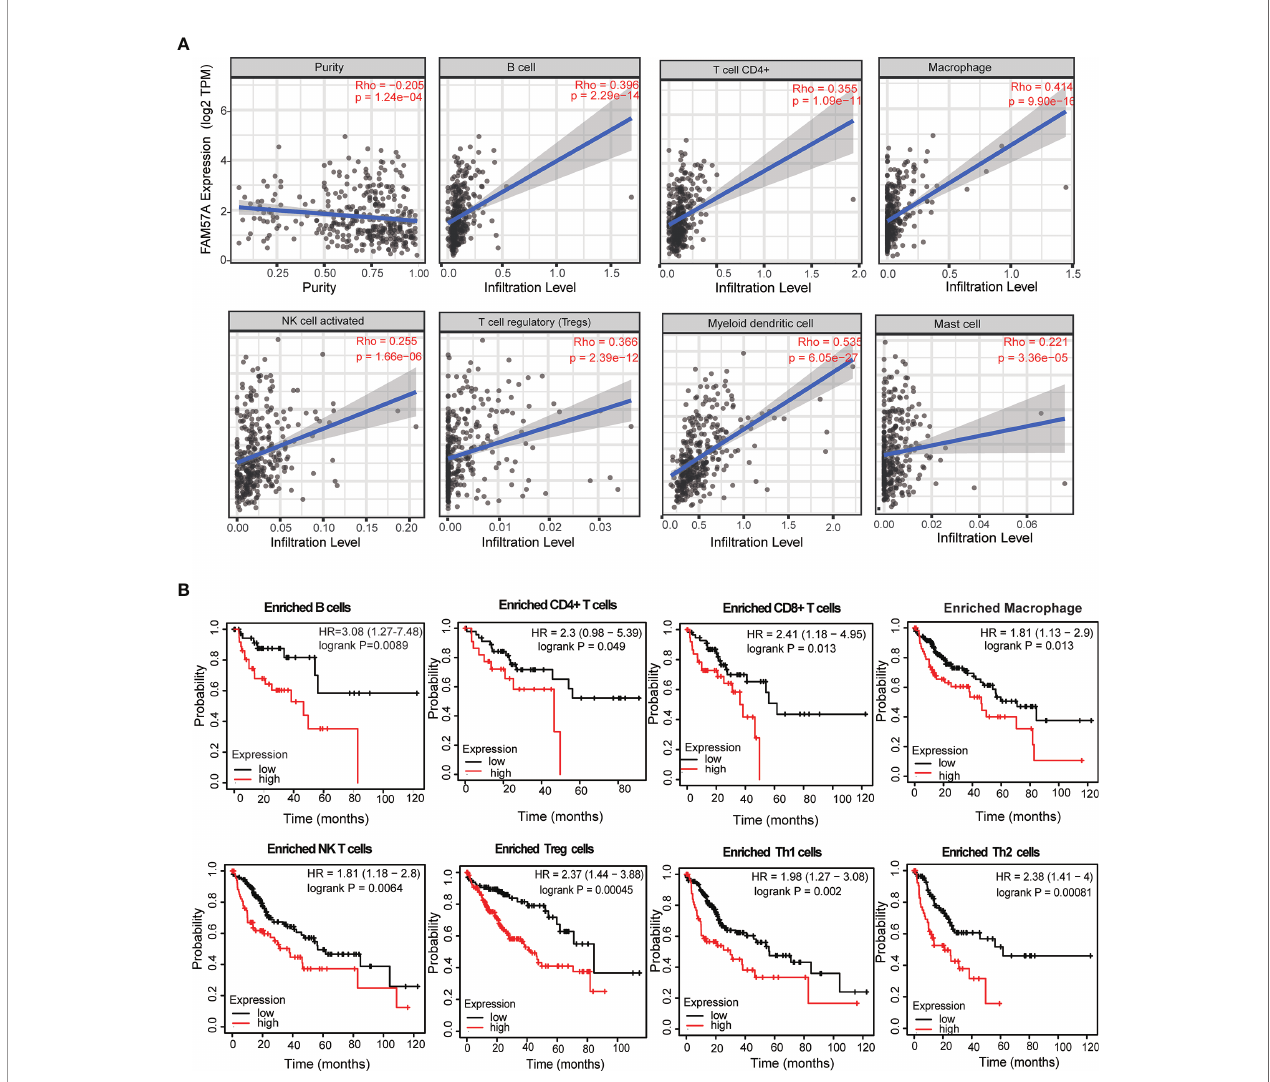
FIGURE 11 | Correlation analysis of the FAM57A level and immune cell in fi ltration levels and survival analysis based on the immune cell subgroup using the TIMER database and the Kaplan – Meier plotter database, respectively. (A) FAM57A expression positively correlates with immune in fi ltration levels of B cells, CD4+ T cells, macrophage cells, NK cells, Tregs, myeloid dendritic cells, and mast cells. (B) High FAM57A level enriched in B cells, CD4+ T cells, CD8+ T cells, macrophages, NK T cells, Treg T cells, Th1 cells, and Th2 cells had worse OS in